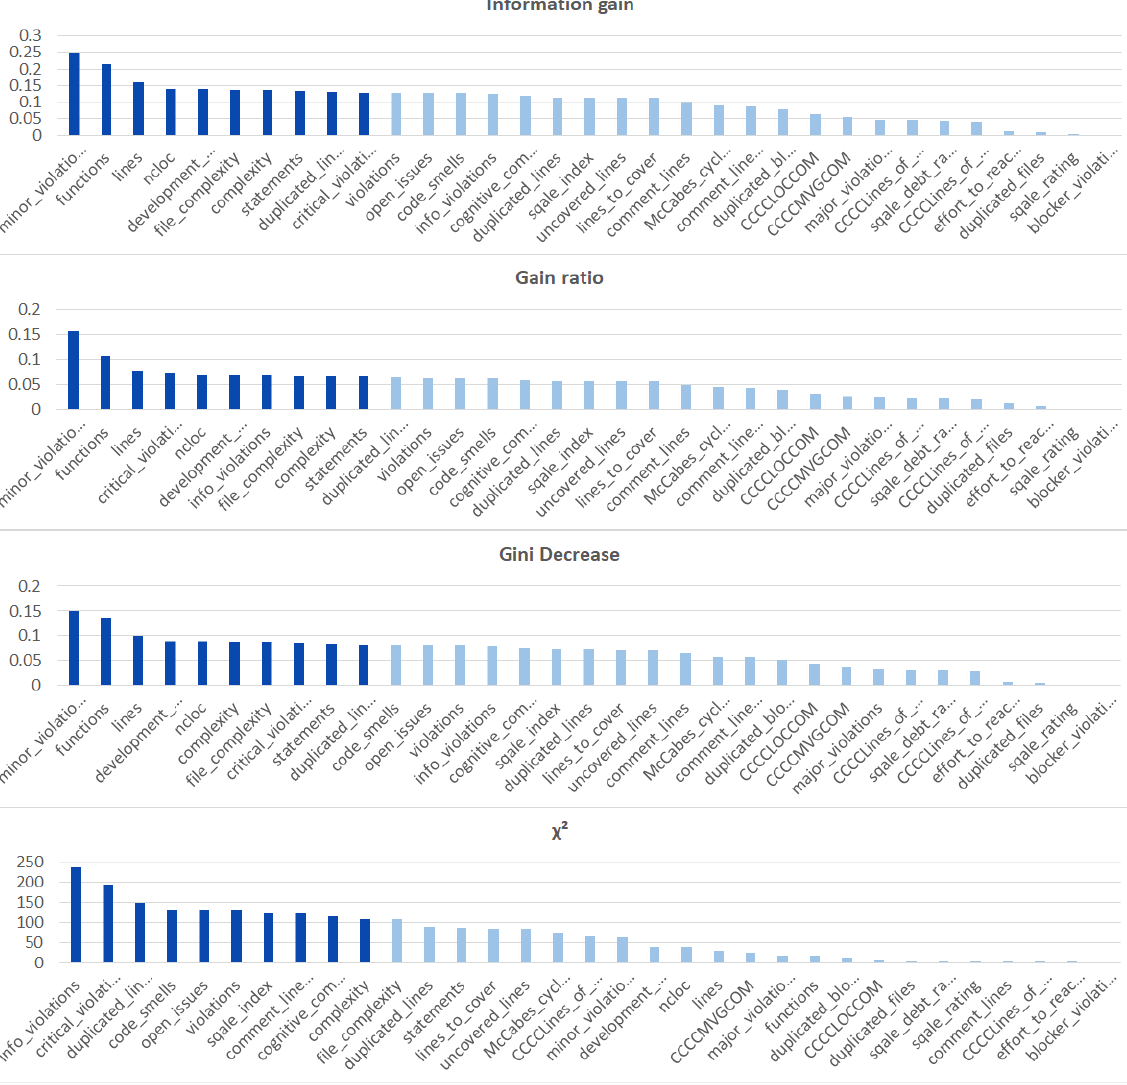
Figure 5. Feature ranks obtained using different types of metrics for the CWE-399 subset of the